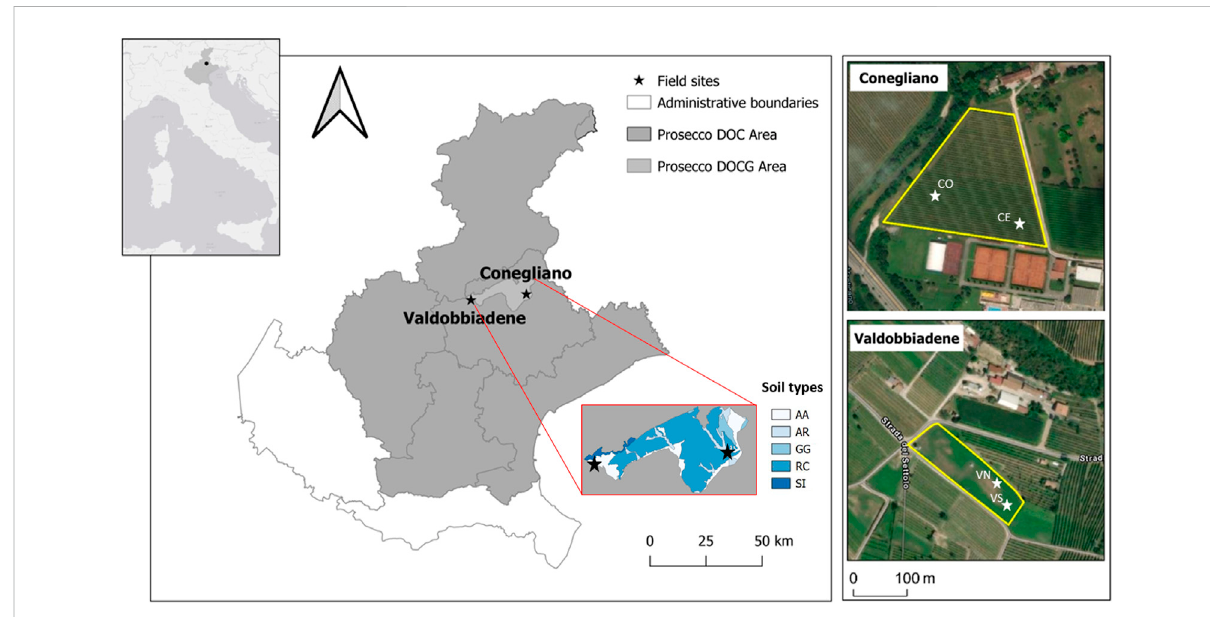
FIGURE 1 LocationoftheexperimentalareaintheVenetoregionandofthetwomonitoredsites(blackstars)withintheProseccoDOCGarea,Conegliano and Valdobbiadene (satellite images on the right). Soil types within the DOCG area — and the corresponding geomorphological origin — are also reported (AA: ancient, gravelly, calcareous high plain; AR: recent high plains and terraces, gravelly and calcareous; GG: Pleistocene moraine amphitheaters consisting of long, arcuate hills; RC: pre-Alpine hilly reliefs placed at the foot of massifs; SI: long and articulated pre-Alpine mountain ridges, consisting of hard and marly limestone) (ARPAV, 2008). The white stars indicate the two monitoring stations identi fi ed in each site with the corresponding